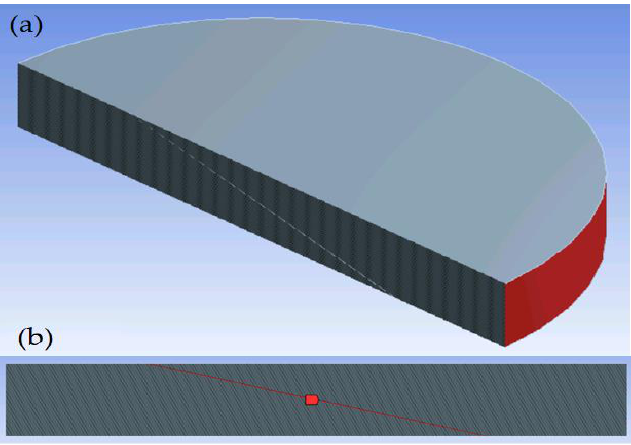
Figure 4. Vertical section for inlet ( a ) and outlet ( b ).